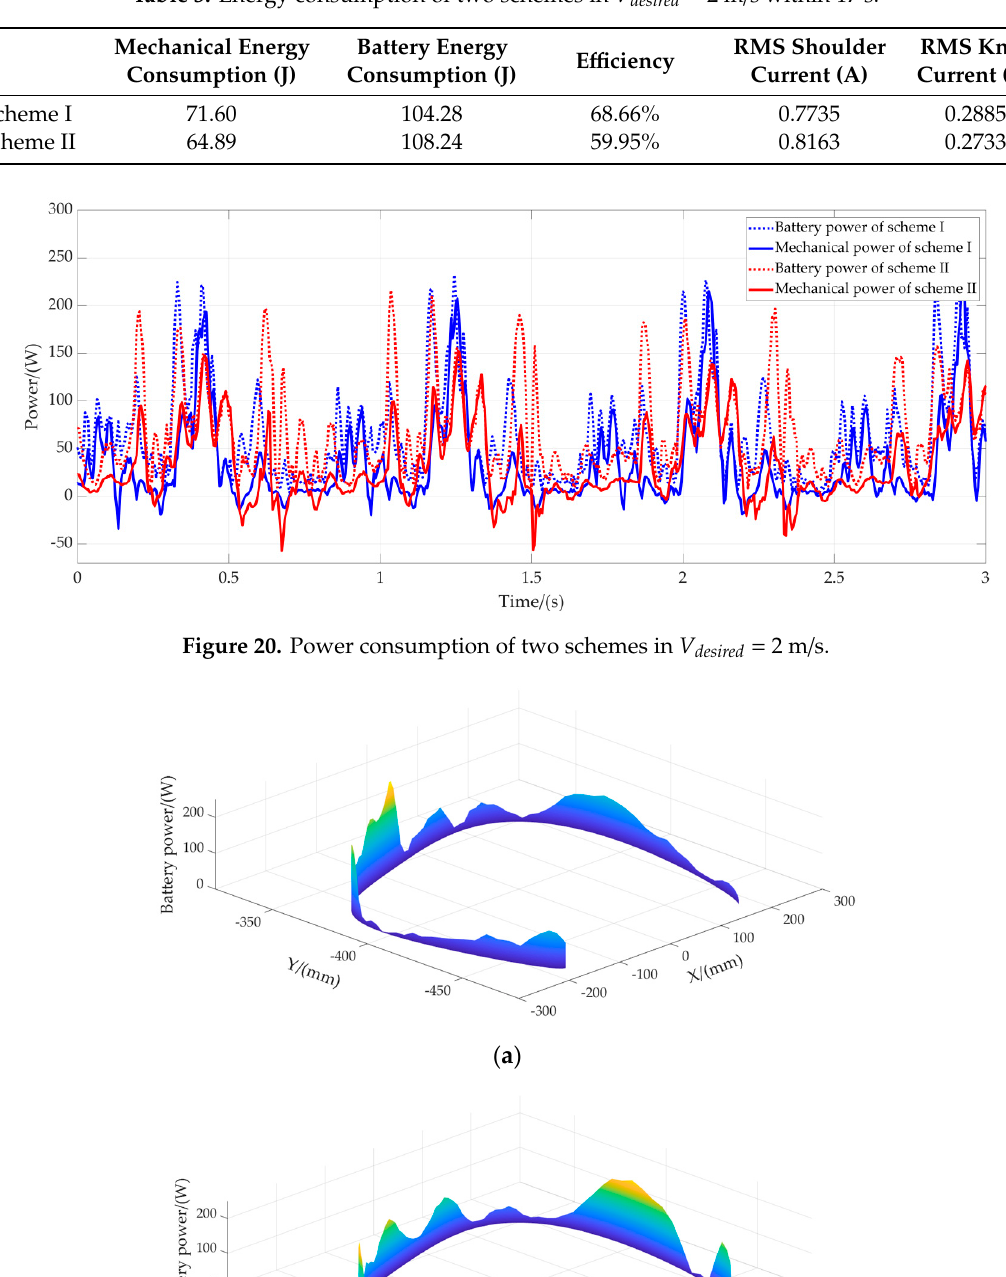
Table 3. Energy consumption of two schemes in V desired = 2 m / s within 17 s.